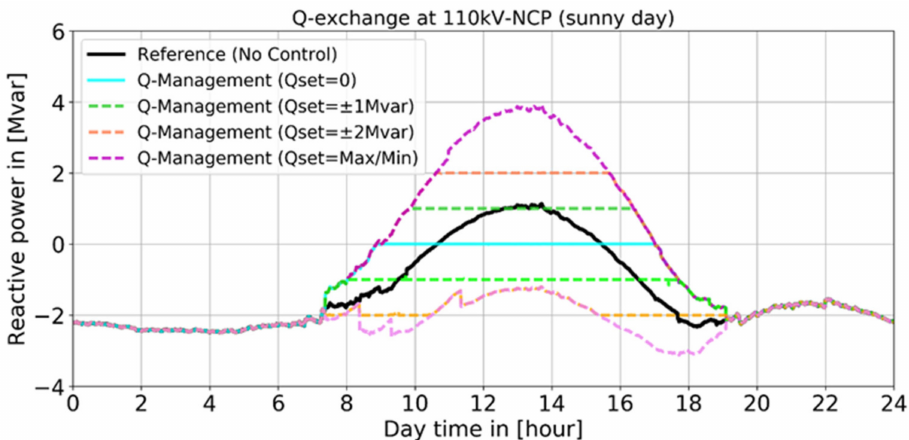
Figure 10. Q exchanges at 110 kV-NCP for simulations with different Q